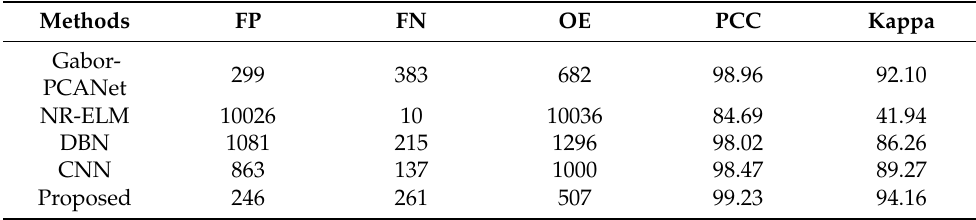
Figure 17. Change detection results on the San Francisco dataset. ( a ) Ground truth. ( b ) Result by Gabor-PCANet. ( c ) Result by NR-ELM. ( d ) Result by DBN. ( e ) Result by CNN. ( f ) Result by our proposed method. Table 4. Change detection results of the San Francisco